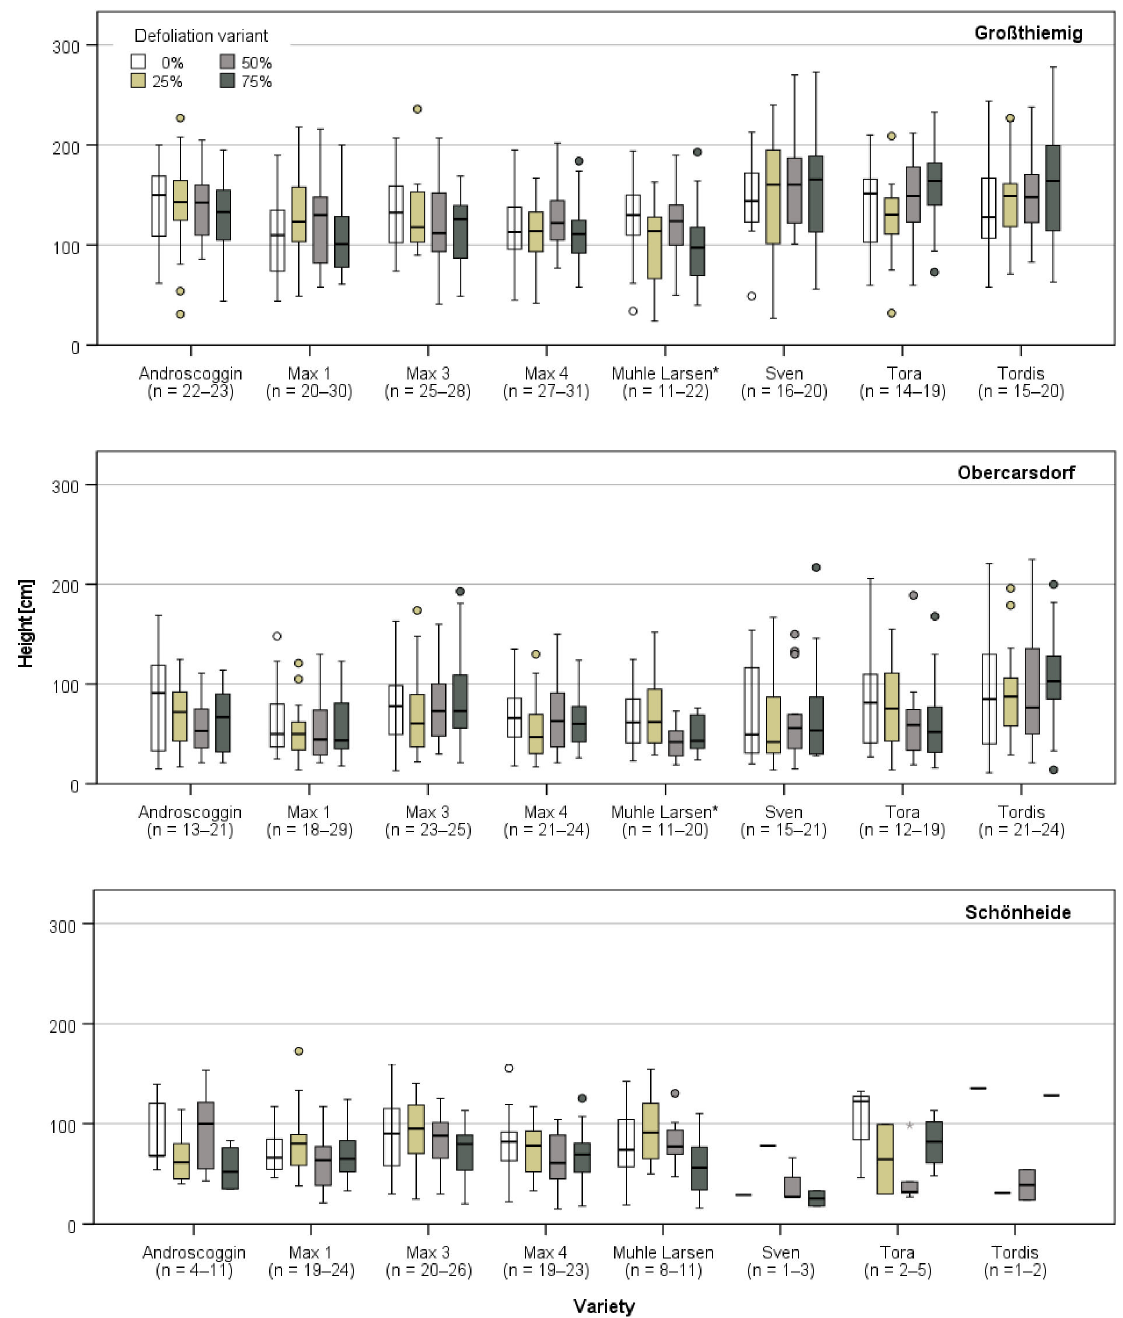
Figure A2. Height of poplar and willow varieties on the three study sites in December 2007 after the first defoliation treatment in July/August 2007, with the exception of the willow varieties in Schönheide (n = range of number of plants per defoliation variant, * statistically significant difference according to ANOVA).